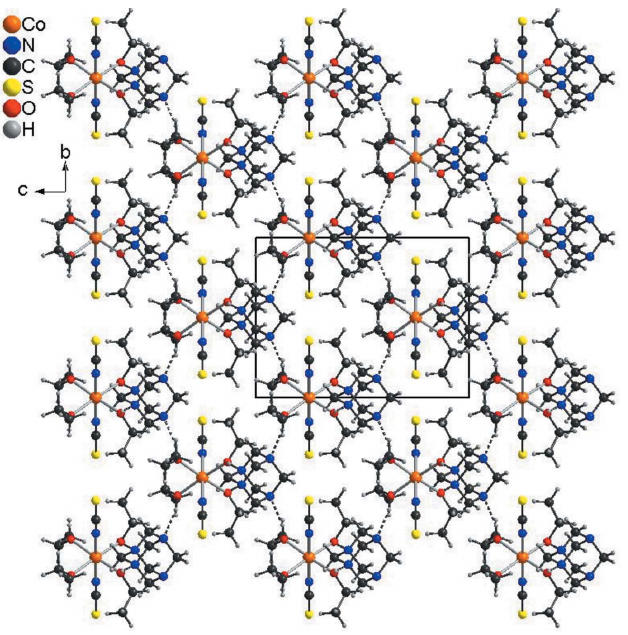
Figure 5 Crystal structure of compound 2 with a view along the crystallographic a - axis with intermolecular O—H (cid:2)(cid:2)(cid:2) N hydrogen bonding shown as dashed